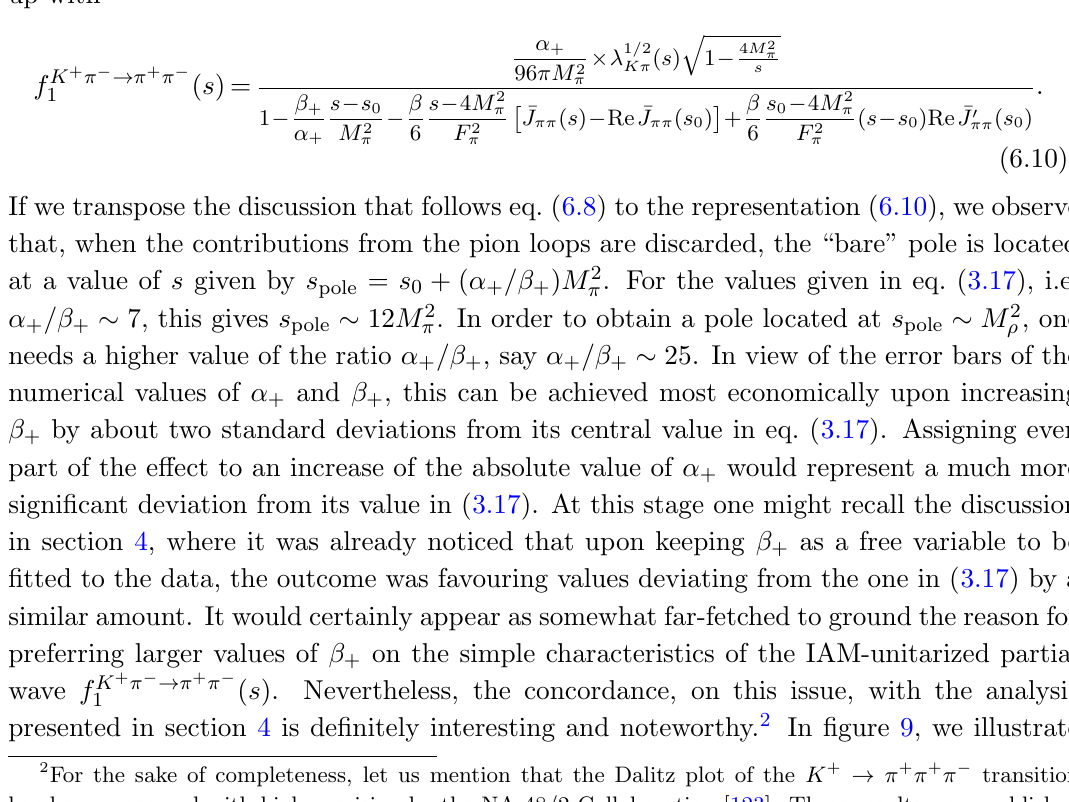
Figure 8 . The left-hand plot shows the absolute value unitarized version (solid line), as a function of s=M 2 (notice that M 2 = 31 M 2 ) and (cid:12) = 1 : 11. The right-hand plot shows the real (dashed line) and (cid:26) (cid:25) imaginary (solid line) parts of the IAM unitarized pion form